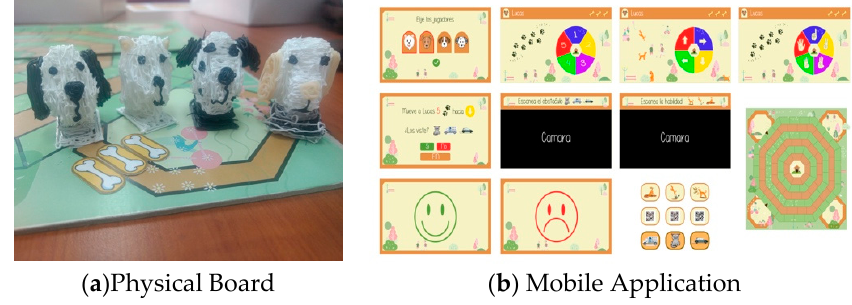
Figure 4. Tangible interface Perdi-Dogs.